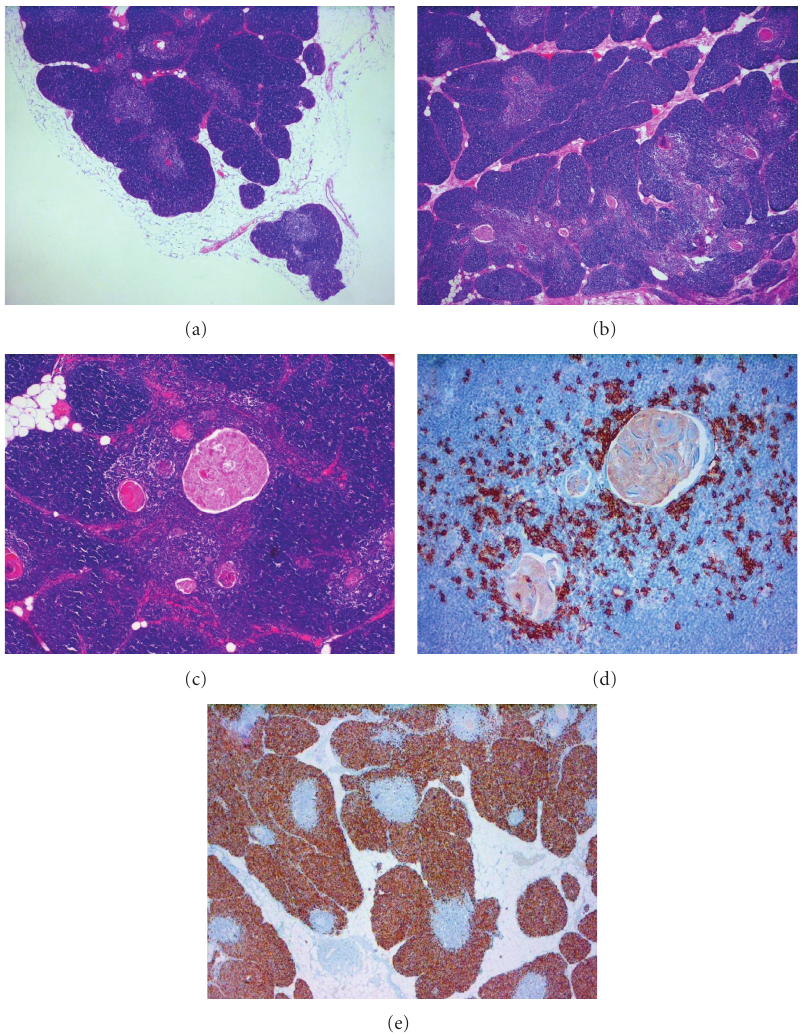
Figure 2: (a) Thymic tissue with adjacent mature fat (hematoxylin and eosin, original magnification × 4). (b) Hyperplastic thymus with lobular structure, divorcing fibrous septa, sometimes interrupted by mature fat and enclosed hyperemic vessels (hematoxylin and eosin, original magnification × 4). (c) Thymic tissue with prominent enlarged Hassall’s corpuscles (hematoxylin and eosin, original magnification × 20). (d) Immunohistochemistry shows CD20 positivity for B lymphocytes surrounding Hassall’s corpuscles (original magnification × 20, methylen blue counterstain). (e) Strong Ki-67 positivity, which demonstrates the high proliferation rate of the cellular elements of thymic tissue. The staining relieves the areas surrounding the Hassall’s corpuscles (original magnification × 4, methylen blue